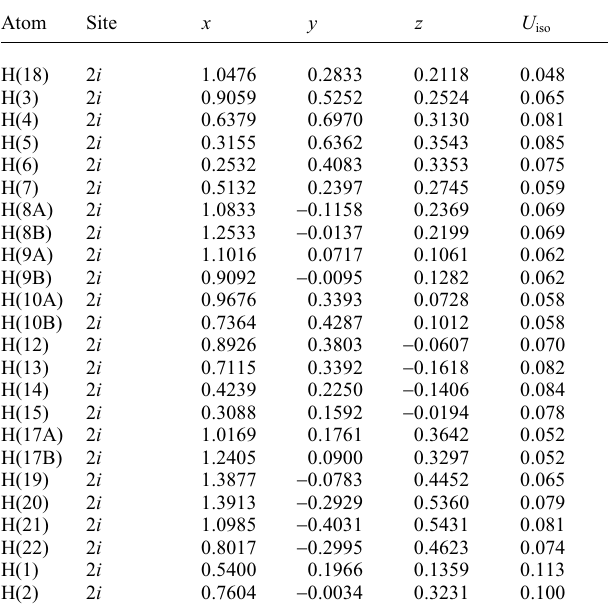
Table 2. Atomic coordinates and displacement parameters (in Å 2 )